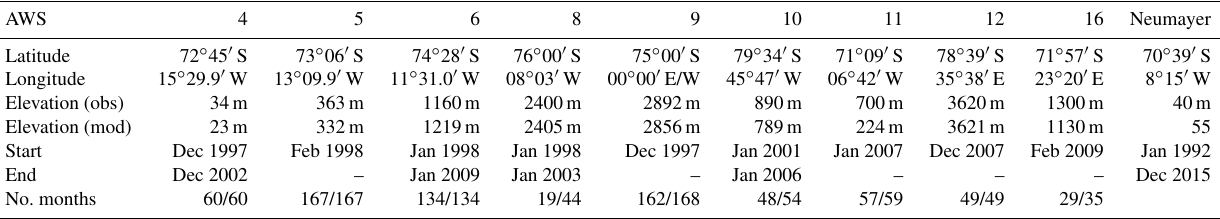
Table 1. The AWS topographic characteristics and period of operation (until December 2011). No. months represents the number of available months over the total months (725/770) of the model period (January 1979–December 2011). If no end time is indicated, the AWS is still operational at the end of 2011. For Neumayer station only cumulative melt is used in this study (Sect. 3.5.5.). Obs is observed; mod is